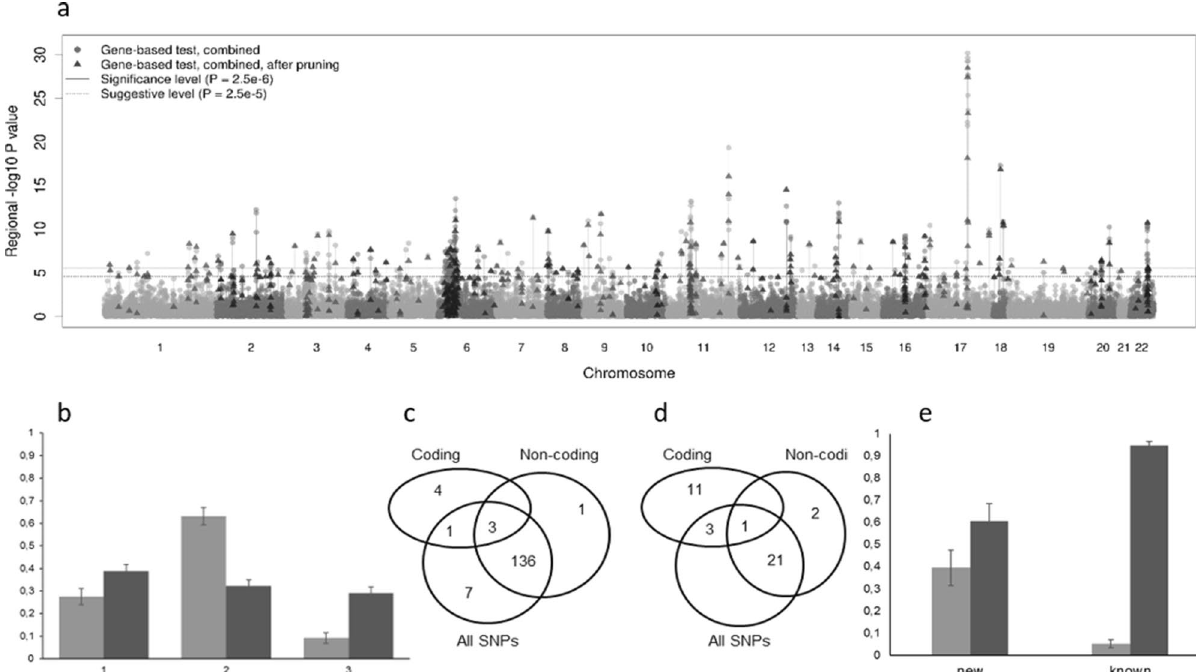
Figure 2. The results of gene-based association analysis. ( a ) Manhattan plot showing the –log 10 transformed p-value of each gene. ( b ) Proportion of genes identified by gene-based association analysis only (1), both gene- based association analysis and position mapping (2) and positional mapping only (3) among confirmed (light gray) and non-confirmed (dark gray) genes. ( c ) Venn diagram showing the overlap of known genes identified using different sets of SNPs. ( d ) Venn diagram showing the overlap of new genes identified using different sets of SNPs. ( e ) Proportion of genes identified using non-coding (dark gray) and protein-coding SNP sets (light gray) in the new and known